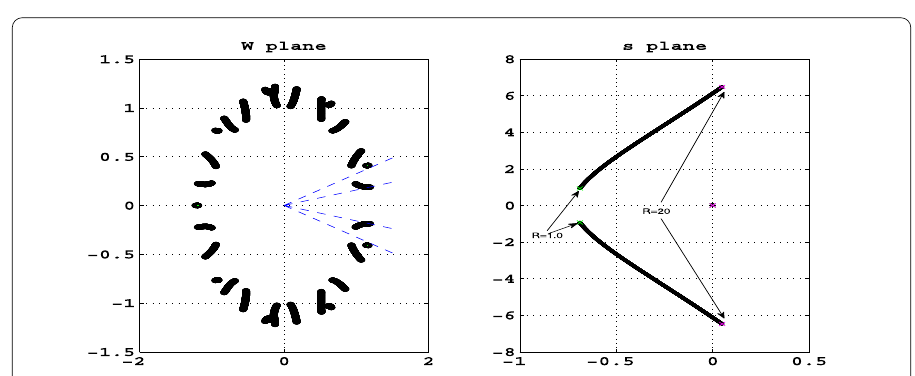
Figure 6 Poles in W -plane and s -plane G = 10 and fractional orders α 2 = α 3 = 1.